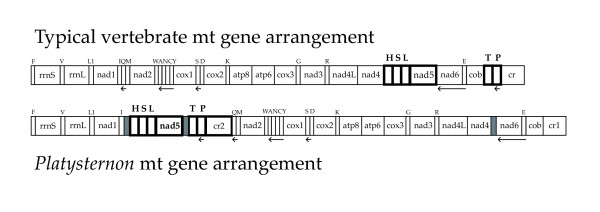
Mt genomic features of Platysternon. Typical arrangement of vertebrate mitochondrial genes including a single control region compared to that of Platysternon. All genes are transcribed from left to right except where indicated by arrows. The genes that are rearranged in Platysternon are indicated in bold while the duplicated control regions are designated by numerals (cr1, cr2). The grey boxes in the Platysternon genome represent non-coding regions (perhaps degraded duplicated copies of genes) that are not present in typical vertebrate mt genomes. This figure illustrates how sequences from two non-adjacent regions were inserted between trnI and trnQ.